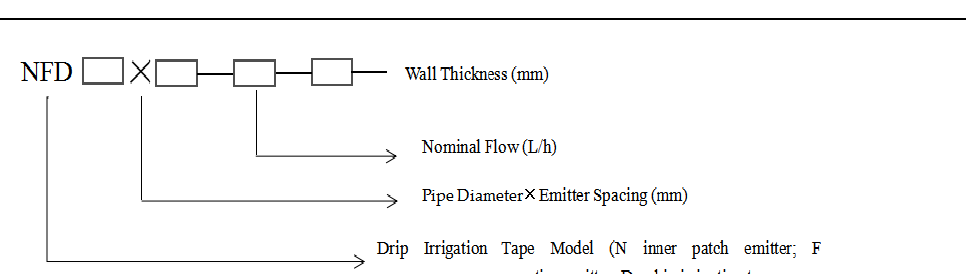
Figure 1. Schematic diagram of the drip irrigation tape model number.